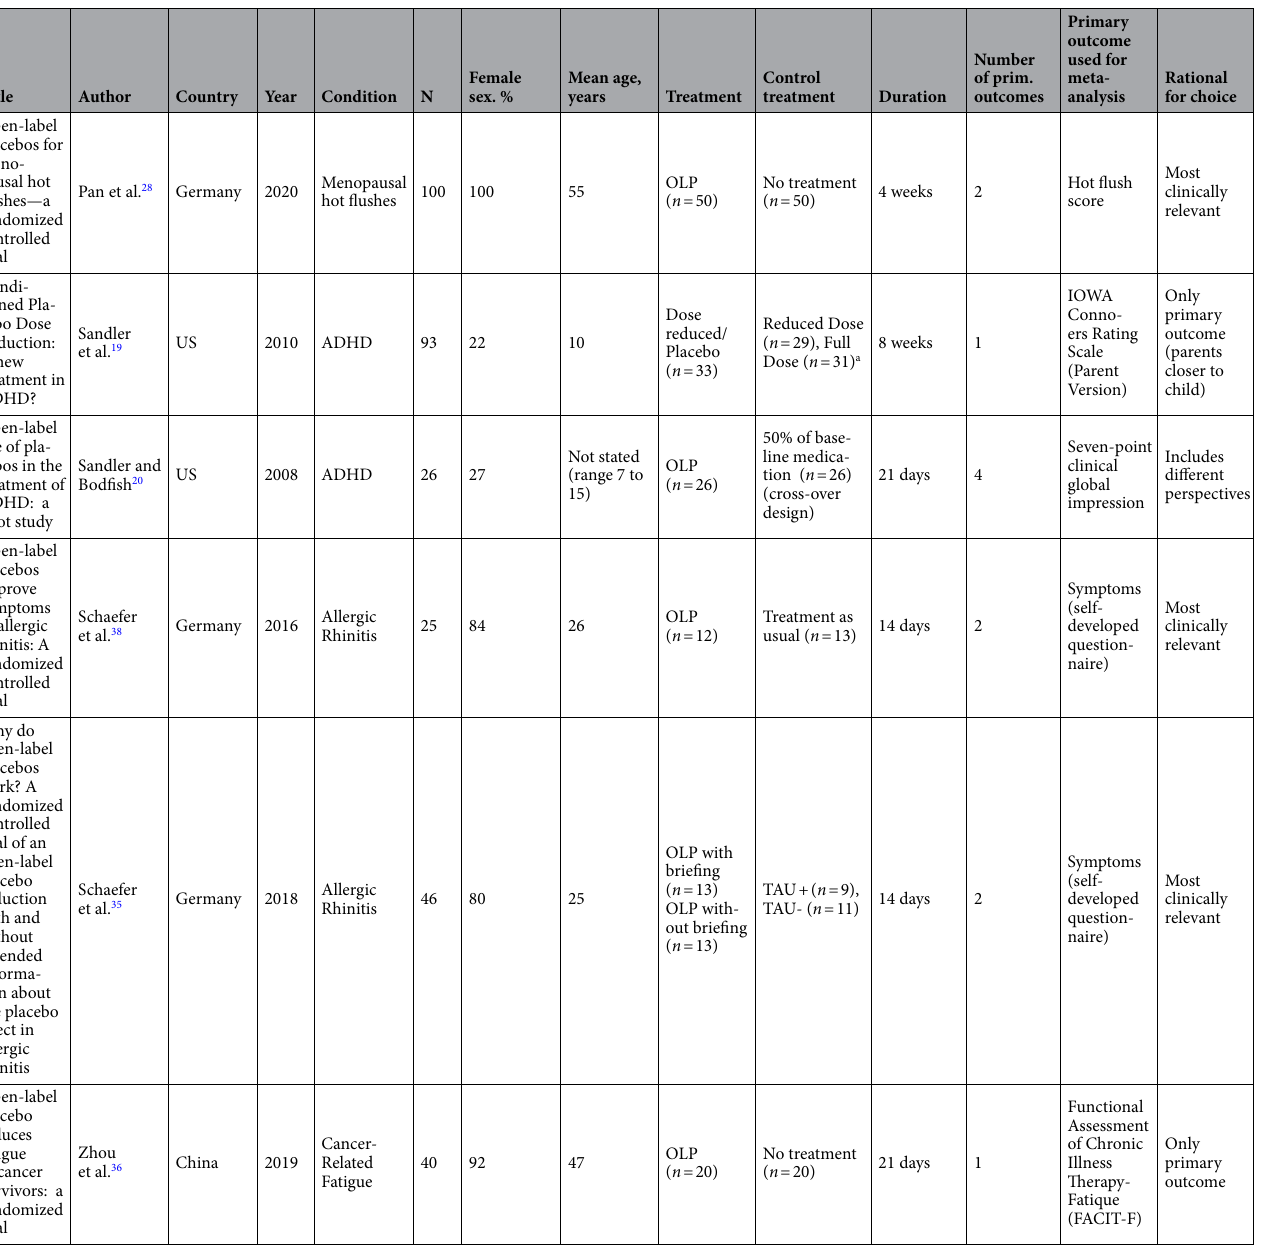
Table 2. Characteristics of included studies. IBS irritable bowel syndrom. a “Full dose group” was excluded. We only compared the “reduced dose” group to the “reduced dose + placebo” group, which was scored as